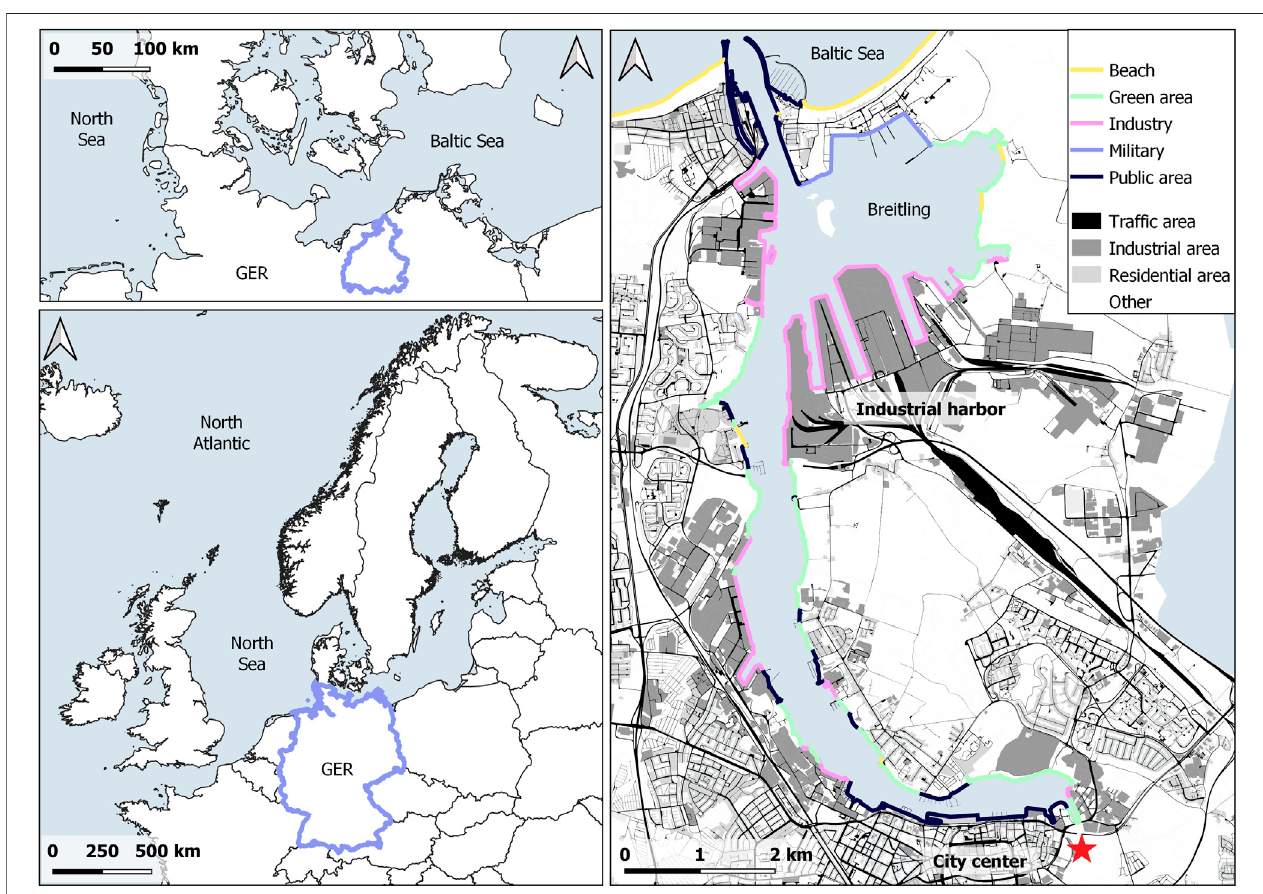
FIGURE 1 | Map of the Warnow catchment (blue line upper left ) located in northwestern Germany (lower left) and the Warnow estuary (right) with land use sections around the estuary. The position of the weir where the Warnow river is discharging into the estuary is indicated by a red star. “ Other ” includes unsealed areas such as forests, agri- and horticulture. Source: Hanse-und Universitätsstadt Rostock (CC BY 4.0).